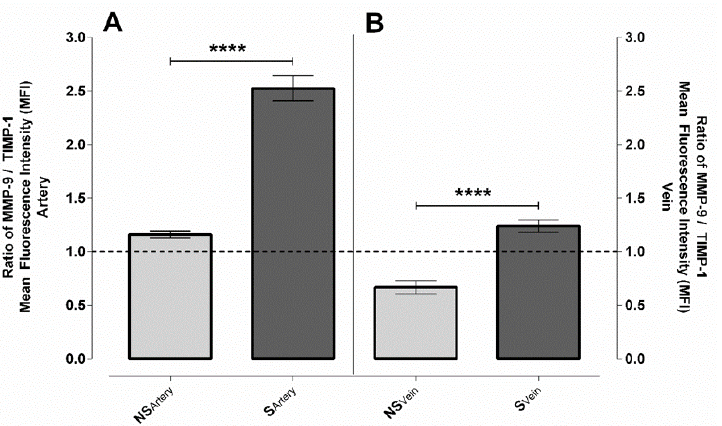
Figure 3. Ratio of MMP-9/TIMP-1 in UC samples with NS and S origins. Graphical representation of the mean fluorescence intensity (MFI) ratios from the immunolabelled arteries ( A ) and veins ( B ) (mean ± SEM). Independently quantified regions and samples: NS-MMP-9 and NS-TIMP-1 (n = 129 arteries and 26 venous regions of interest from 4 independent samples); S-MMP-9 and S-TIMP-1 (n = 144 arteries and 26 venous regions of interest from 4 independent samples). Statistical analysis was performed by using an unpaired t -test followed by a Mann–Whitney test to compare ranks on the raw dataset (**** p ≤ 0.0001) .